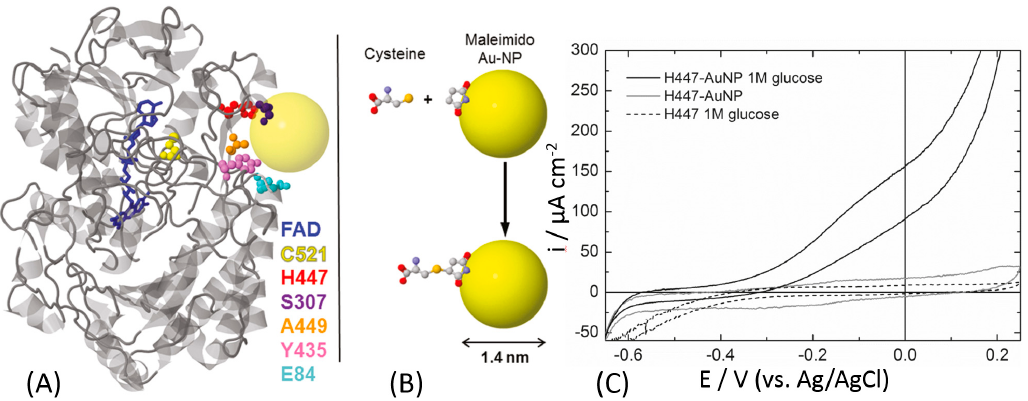
Figure 12. ( A ) Ribbon diagram of a GOx monomer (from A. niger ) with the FAD molecule shown in blue. The amino acid residues targeted for mutagenesis are highlighted as space-filling models: cysteine (yellow), histidine (red), serine (purple), alanine (orange), tyrosine (pink), and glutamate (light blue). The yellow sphere represents an idealized Au nanoparticle (Au-NP) on the same scale as GOx. ( B ) Schematic drawing of the covalent-binding chemistry of cysteine to a maleimide-modified Au nanoparticle. The molecules are displayed as ball-and-stick: carbon (gray), oxygen (red), nitrogen (blue), and sulfur (yellow). ( C ) Cyclic voltammograms of H447C-Au-NP conjugates on a gold electrode in the presence (black line) and absence (gray line) of 1 M glucose (N 2 -saturated buffer, pH 7, 10 mV s − 1 ). The cyclic voltammogram for unconjugated H44C is shown as a dotted line. The H447C-Au-NP conjugates in the presence of glucose exhibit enzymatic glucose oxidation starting at ca. − 400 mV. The definition of all used mutants and their abbreviate names can be found in ref. 157. (The figure was adopted from ref. 157 with permission.).